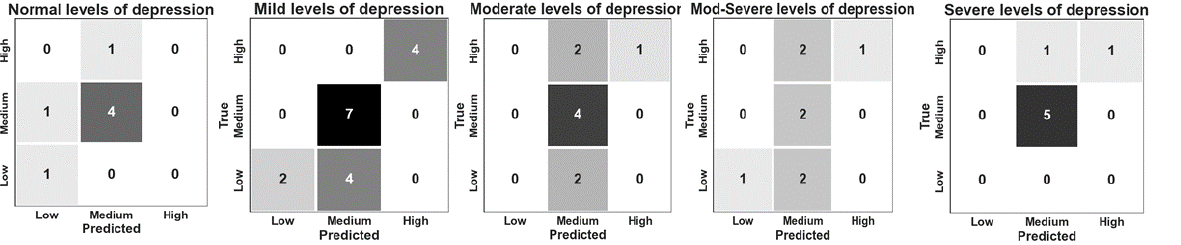
Figure 8. The confusion matrix results of the practitioner’s levels of competence (low, medium, high) based on the patient’s level of depression (normal, mild, moderate, moderately severe, and